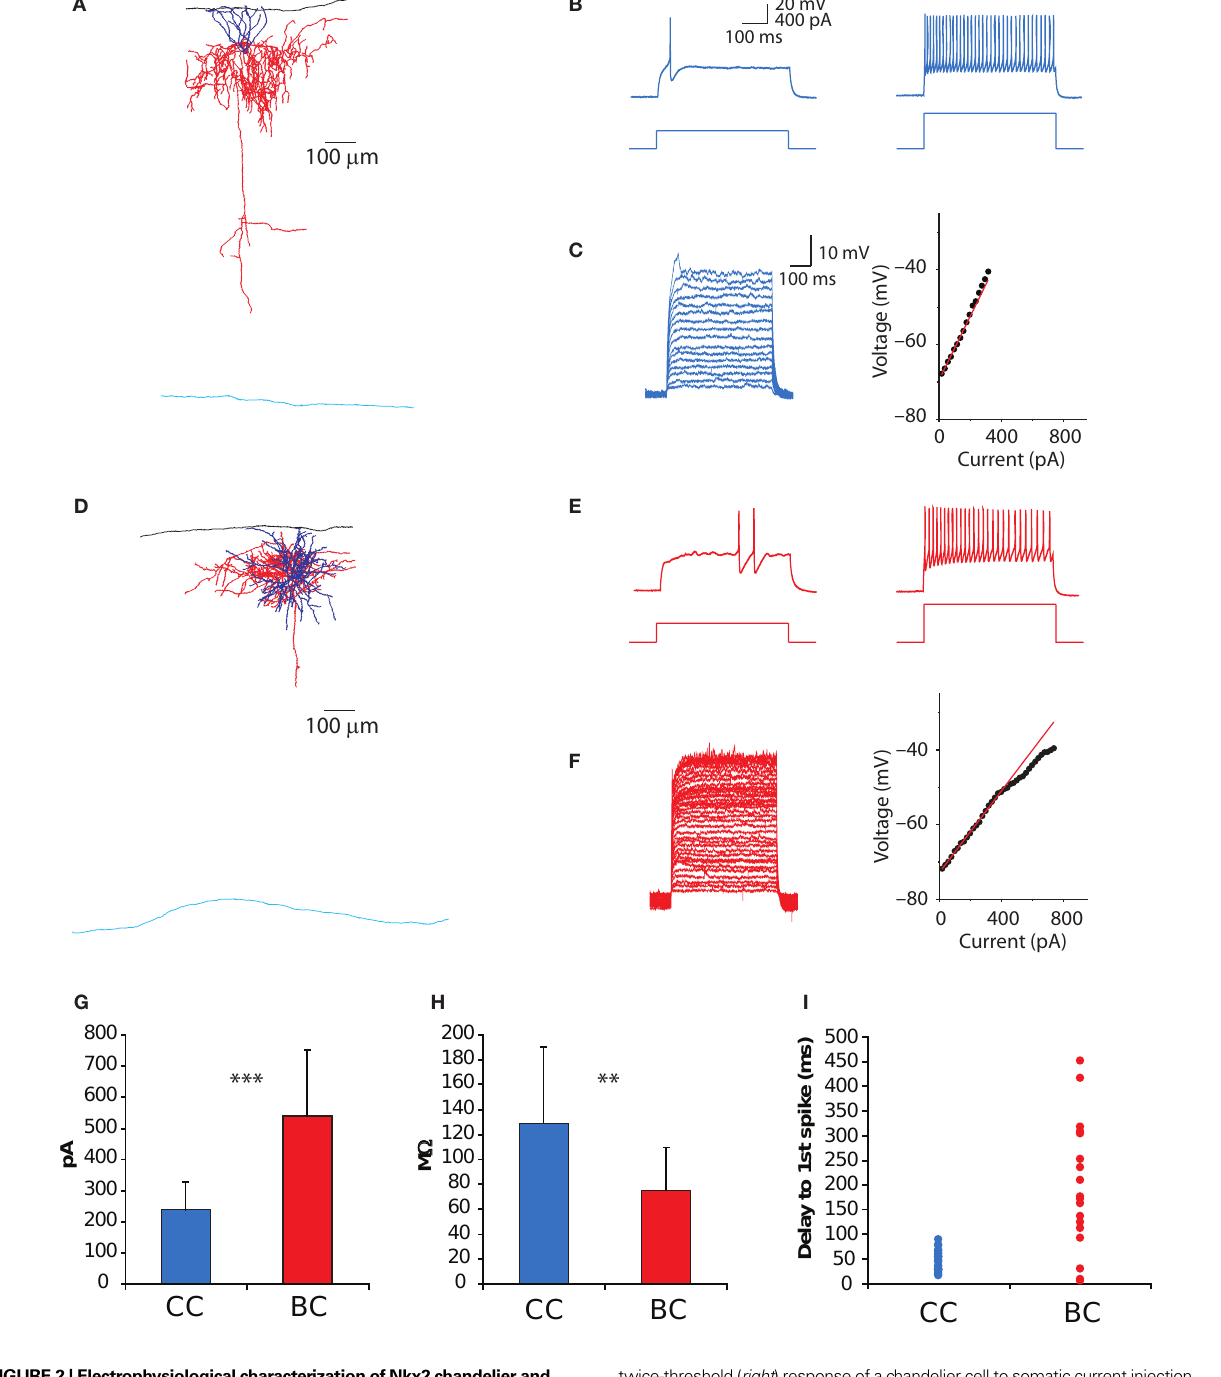
twice-threshold ( right ) response of a chandelier cell to somatic current injection. (C) Subthreshold current–voltage relationship. (D–F) As for (A–C) , for basket cells. (G–I) Comparison of rheobase (G) , input resistance (H) and fi rst spike latency (I) for the two cell types. Error bars represent SD. ***: p < 0.001; **: p <